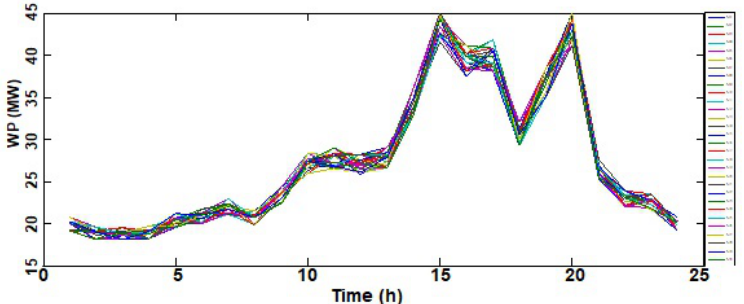
Figure 7. The WP with 30 alternative scenarios.